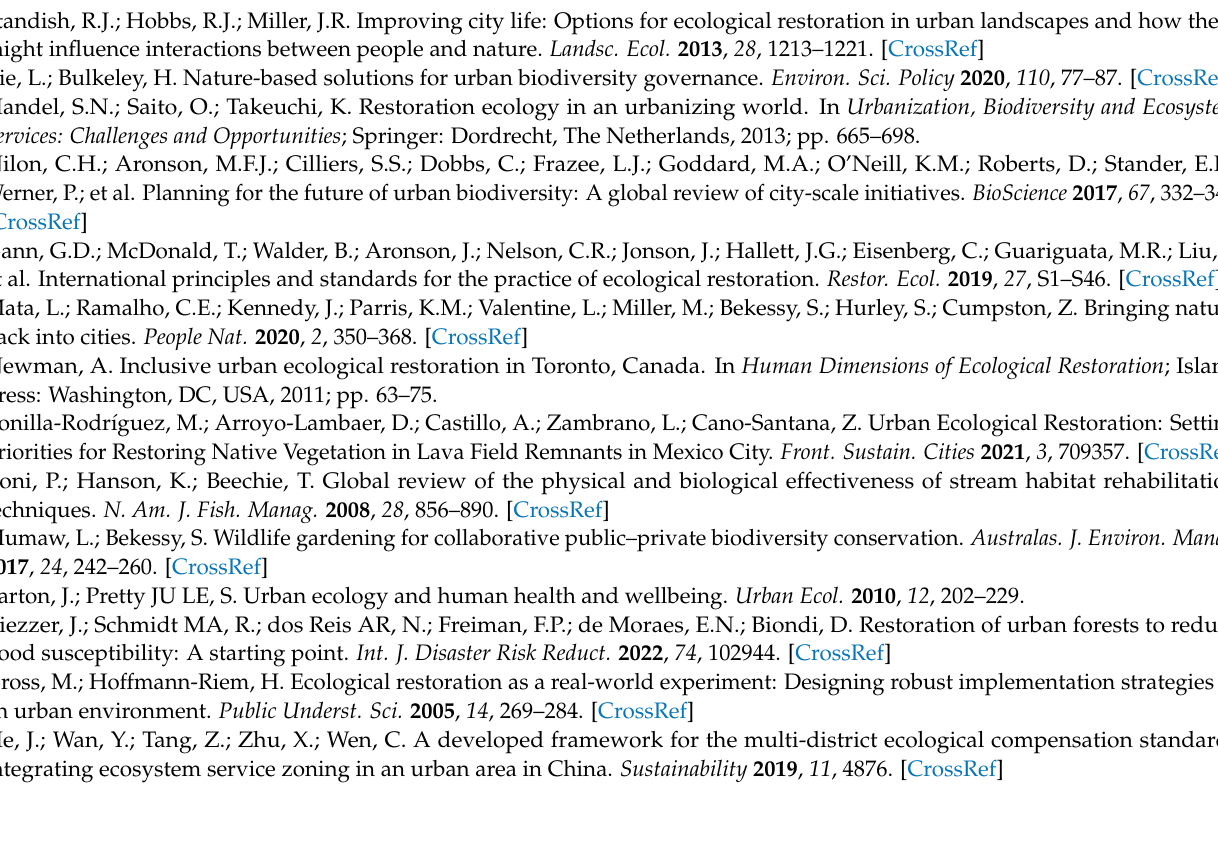
Figure B3. Grove Park’s planting zone. The shallow depressions ecological unit suggests that planting kahikatea semi-swamp forest species around the remnant could be appropriate. Some of the appropriate species for planting the grassy areas of this shallow depressions ecological unit include Cordyline australis , Myrsine australis , and Melicytus ramiflorus . Species suited to the understory of this ecological unit include Beilschmiedia tawa , Syzygium maire and Laurelia novae-zelandiae [18].